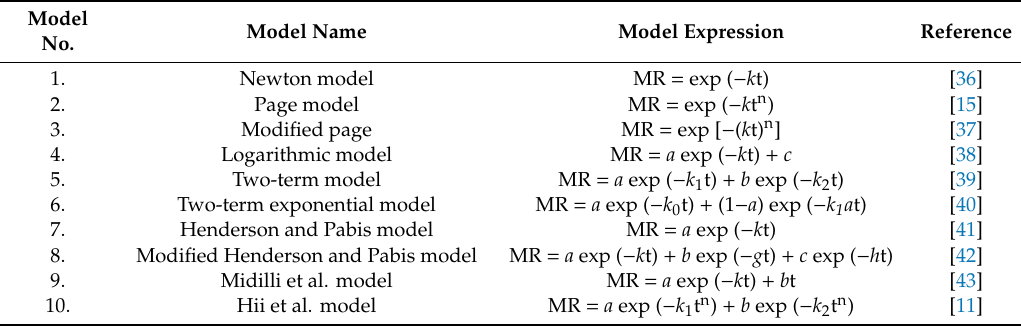
Table 1. Mathematical thin-layer drying